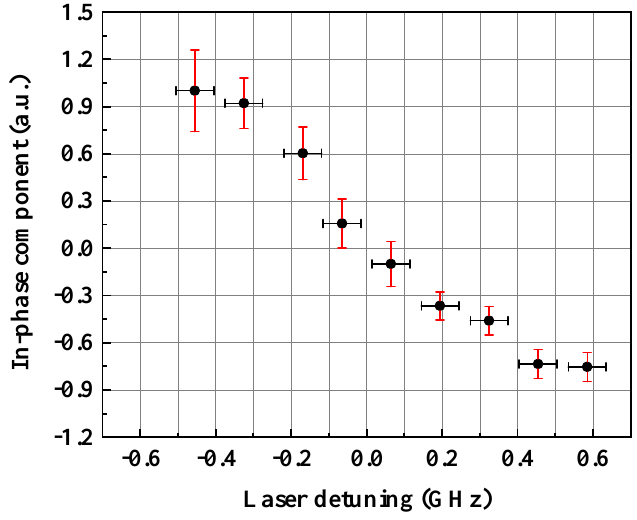
Figure 3. The in-phase component of the magnetic resonance signal with different laser detuning. For the in-phase component, the error bar is from eight individual measurements. There are some error sources that can affect the in-phase signal, i.e., the laser intensity fluctuations, the B 1 -field frequency shift, the magnetic field gradient, the phase shift setting in the lock-in amplifier and the collision shift. For the laser frequency detuning, the error bar is from the resolution limit of the wave meter ( ∼ 50 MHz) that we use to monitor the laser frequency.